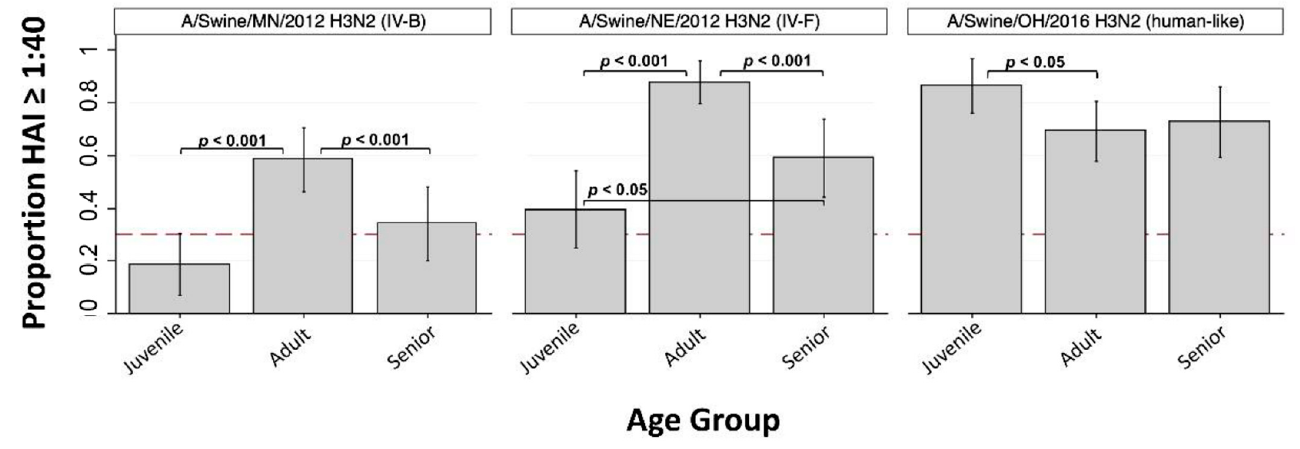
Figure 3. Seroprotection rate (SPR) against H3 cluster IV-B, IV-F, and human-like IAV-S by age group ( n = 3). Bar height indicates proportion of individuals with HAI antibody titer ≥ 1:40 seroprotection rate (SPR) within Juvenile (<18 years old), Adult (18 to 49 years old), and Senior ( ≥ 50 years old) age groups. Dashed red line at y = 0.3 corresponds to SPR of 30%. Vertical spikes and caps indicate 95% confidence interval of the proportion. Significant difference in proportions between groups are indicated (when present) by horizontal brackets and p-values (Pearson’s chi-squared).